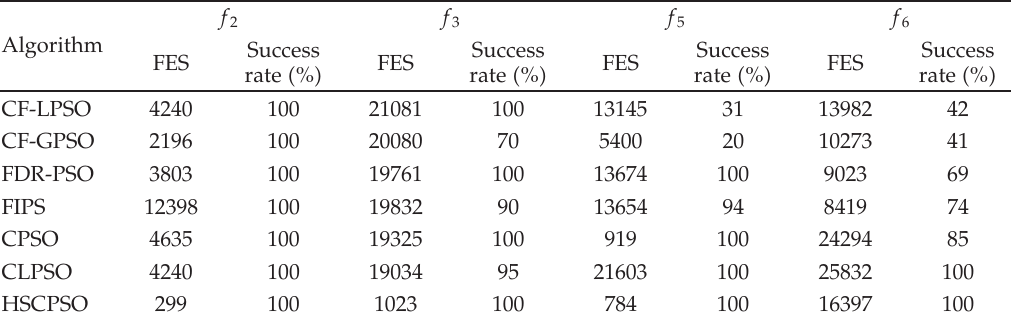
Table 6: Robustness analysis after 3